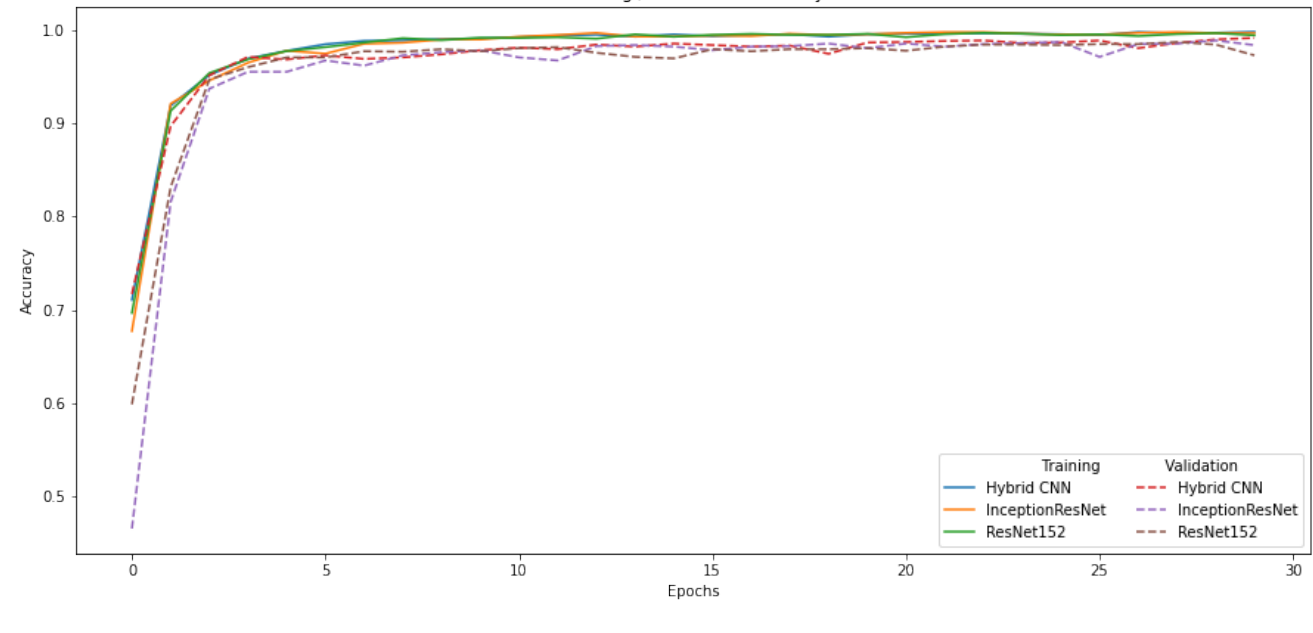
Figure 5. Comparative training accuracy of all